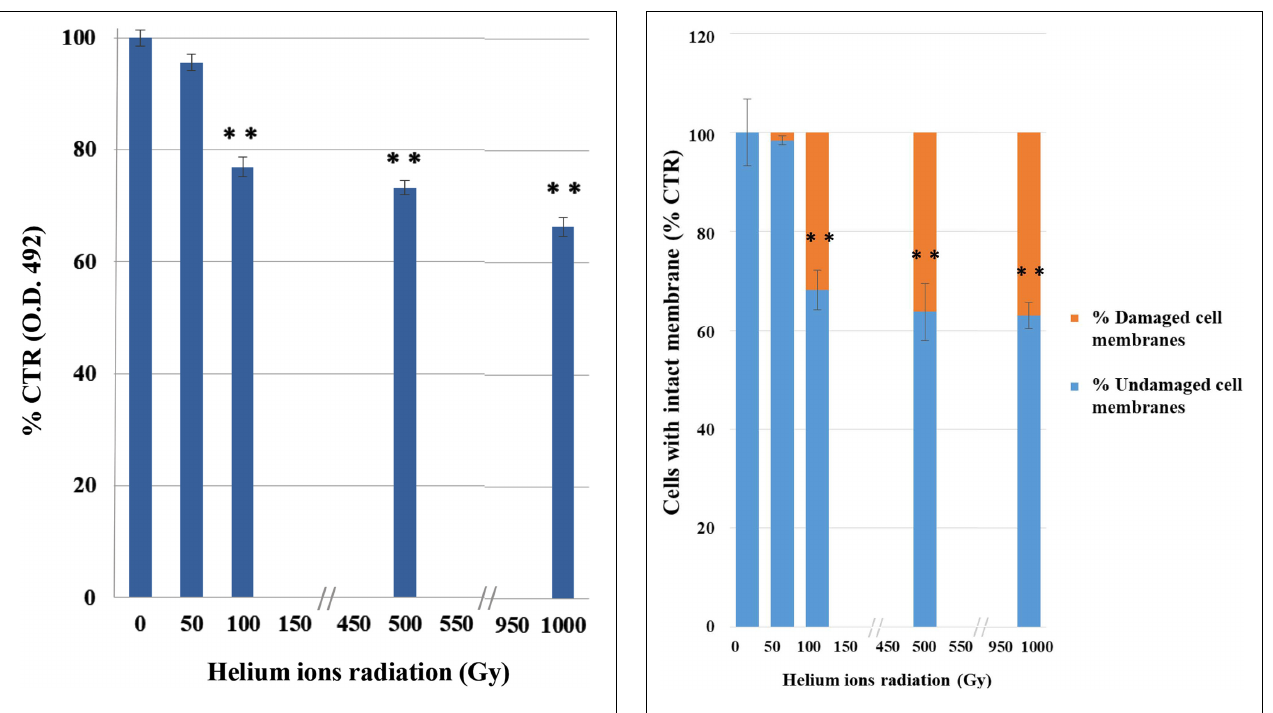
FIGURE 3 | Results of PMA assay coupled with qPCR after helium ions radiation: 50, 100, 500, and 1,000 Gy. The graph shows percentages of C. antarcticus cells with intact membrane, normalized with the control. Percentages of C. antarcticus cells with damaged membrane (Red), and corresponding percentages of cells (Blue) with intact membrane. Significant differences were calculated by Tukey test with ∗∗ p >